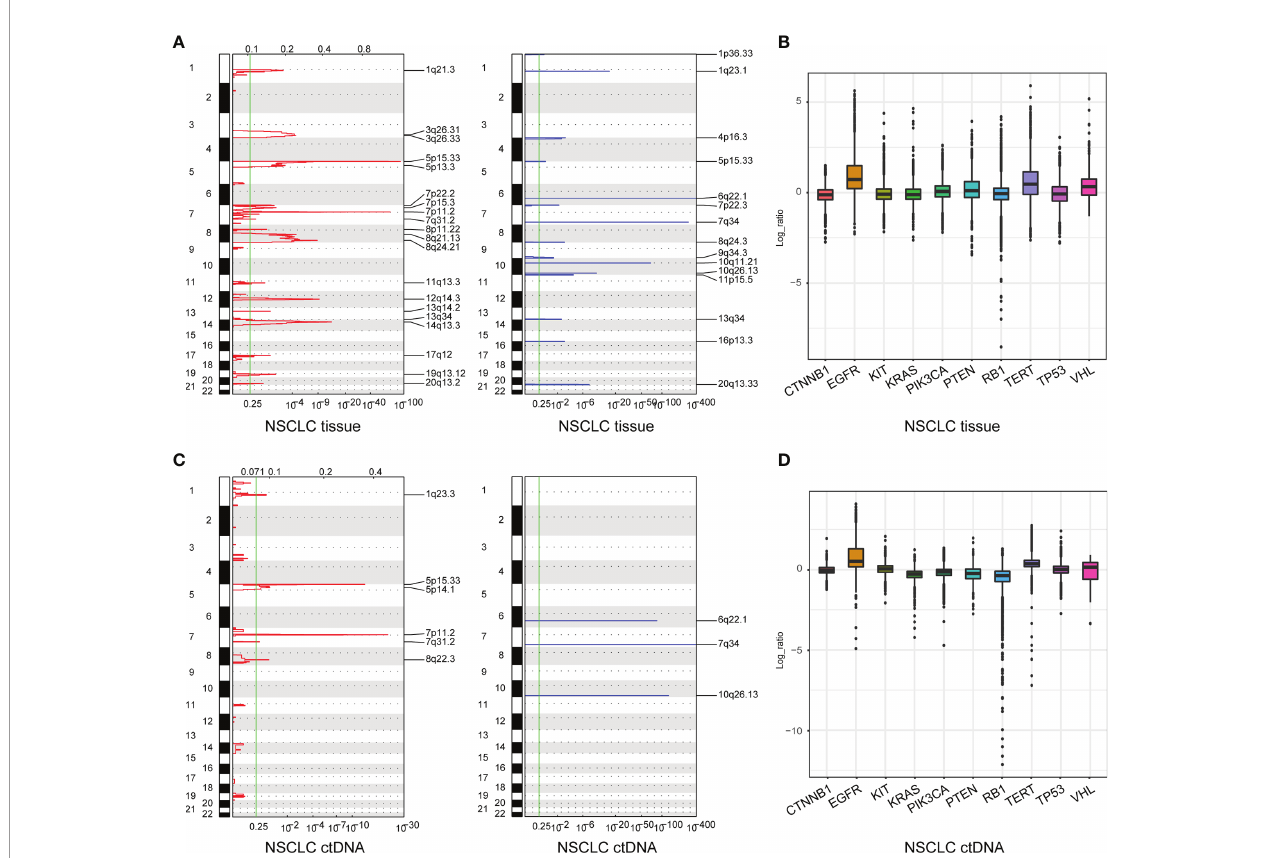
FIGURE 2 | Somatic copy number alterations (SCNAs) of NSCLC derived from tumor tissue DNA (n = 213) (A) and ctDNA (n = 139) (C) . SCNAs in NSCLC are plotted by chromosomal location (vertical axis) by CNVkit. The 10 genes in the hybridization capture-based NGS panel of 95 genes (B, D)